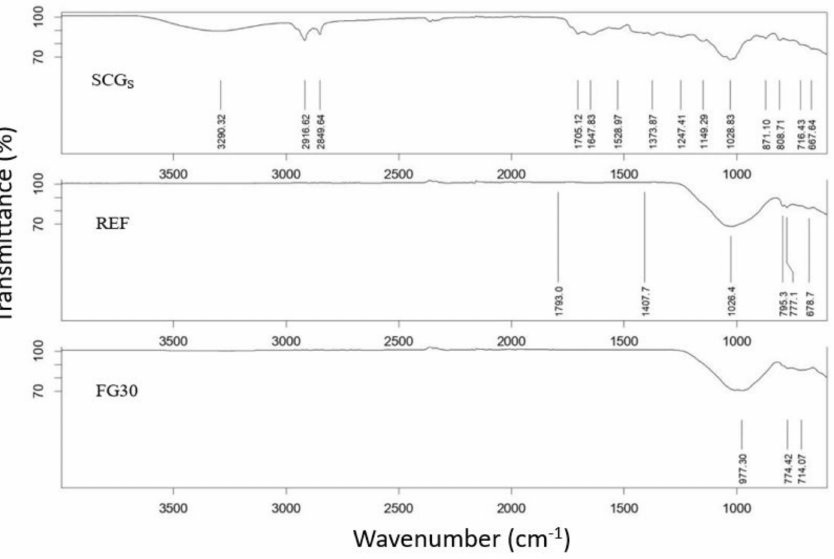
Figure 1. FTIR spectra of SCGs as received (SCGs); matrix composition without fertilizer glass, and matrix composition with 30 wt.% of fertilizer